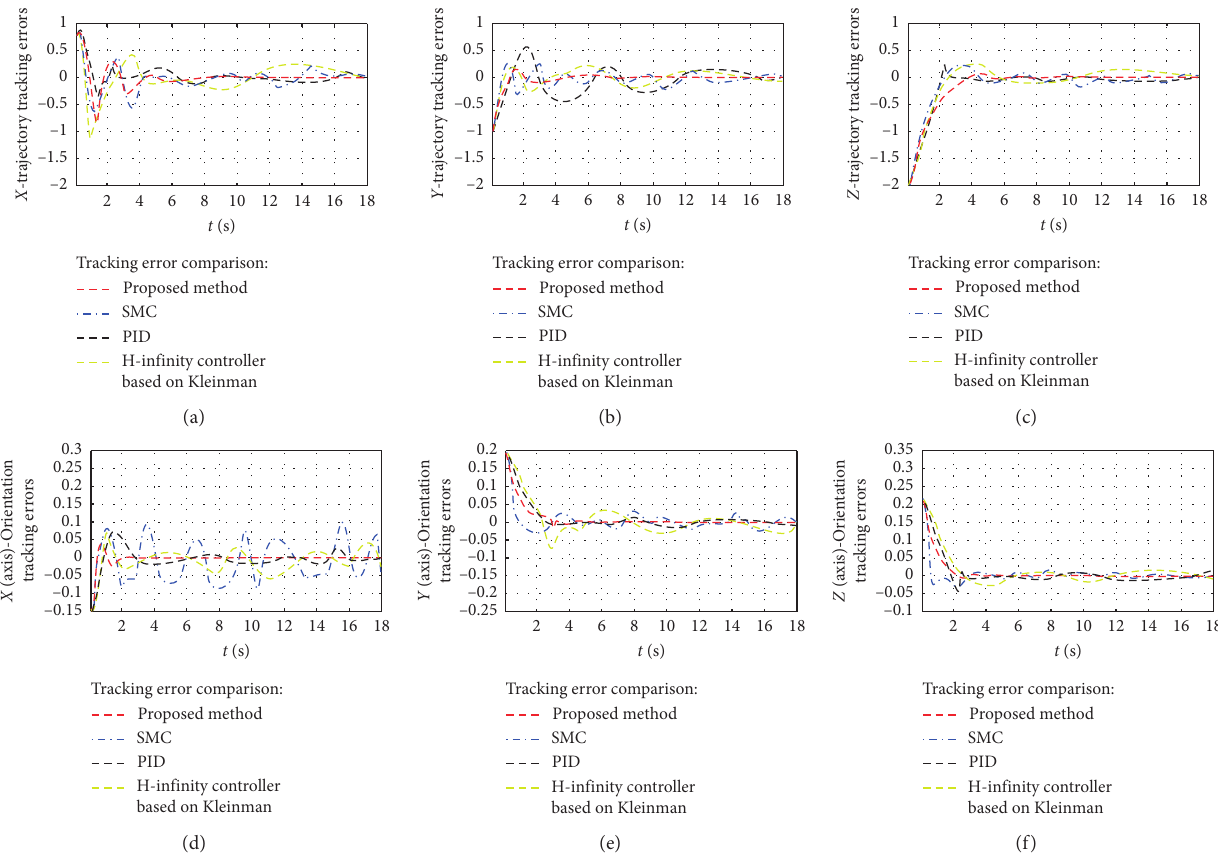
Figure 10: Tracking error comparison of the moving end effector by the proposed method, SMC, PID, and H